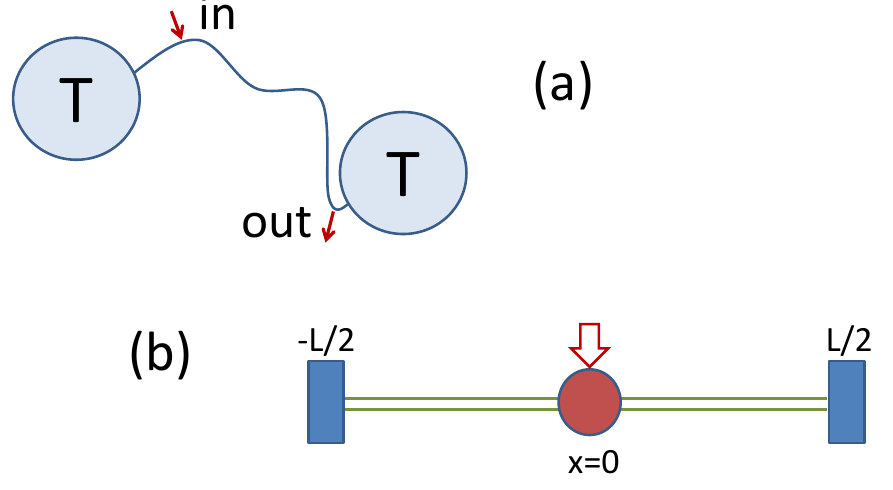
Figure 2. Sketch of the drift-based transport mechanism discussed in Section 4: ( a ) thin filament connecting two particle reservoirs with temperature T; and ( b ) docking (red